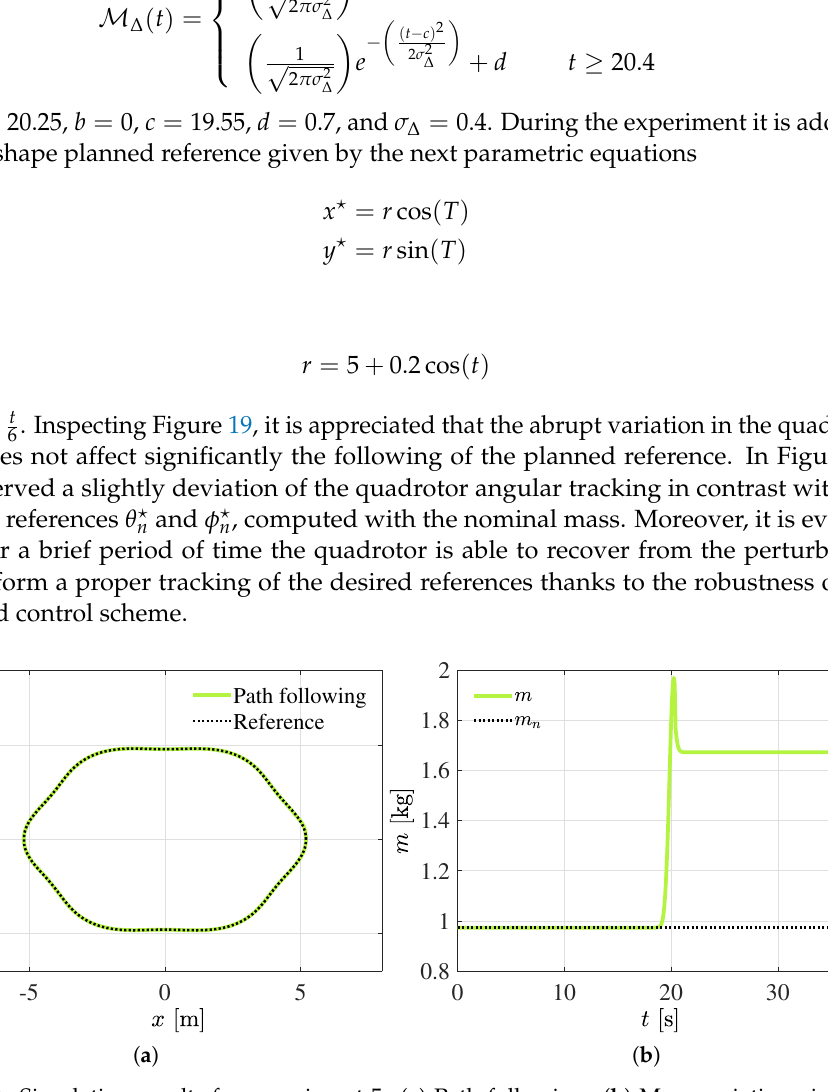
Figure 19. Simulation results for experiment 5. ( a ) Path following. ( b ) Mass variation given by Equation